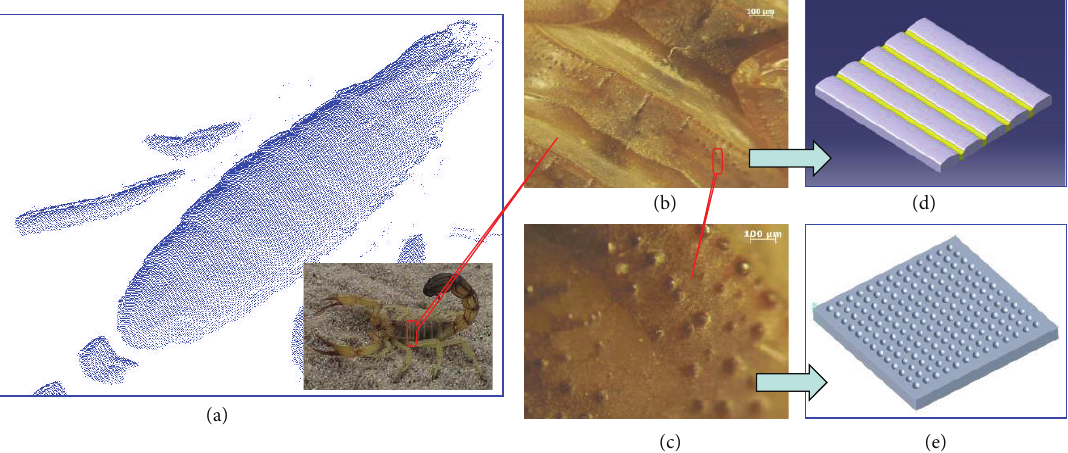
Figure 1: The dorsal surface of the scorpion: (a) scanned data using a laser scanner; (b) the groove of scorpion back; (c) the convex hull of scorpion back; (d) bionic groove pattern; (e) bionic convex